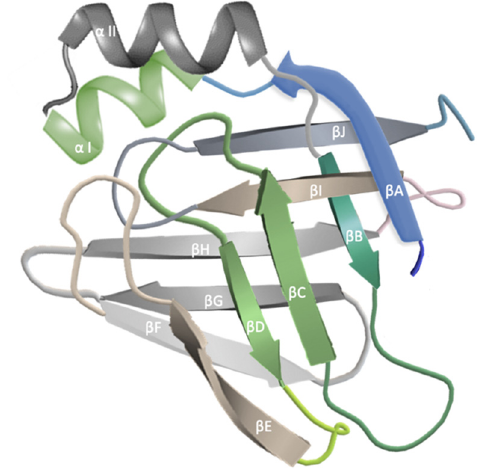
Figure 1. General overview on FABPs’ structure, based on [ 17–19].